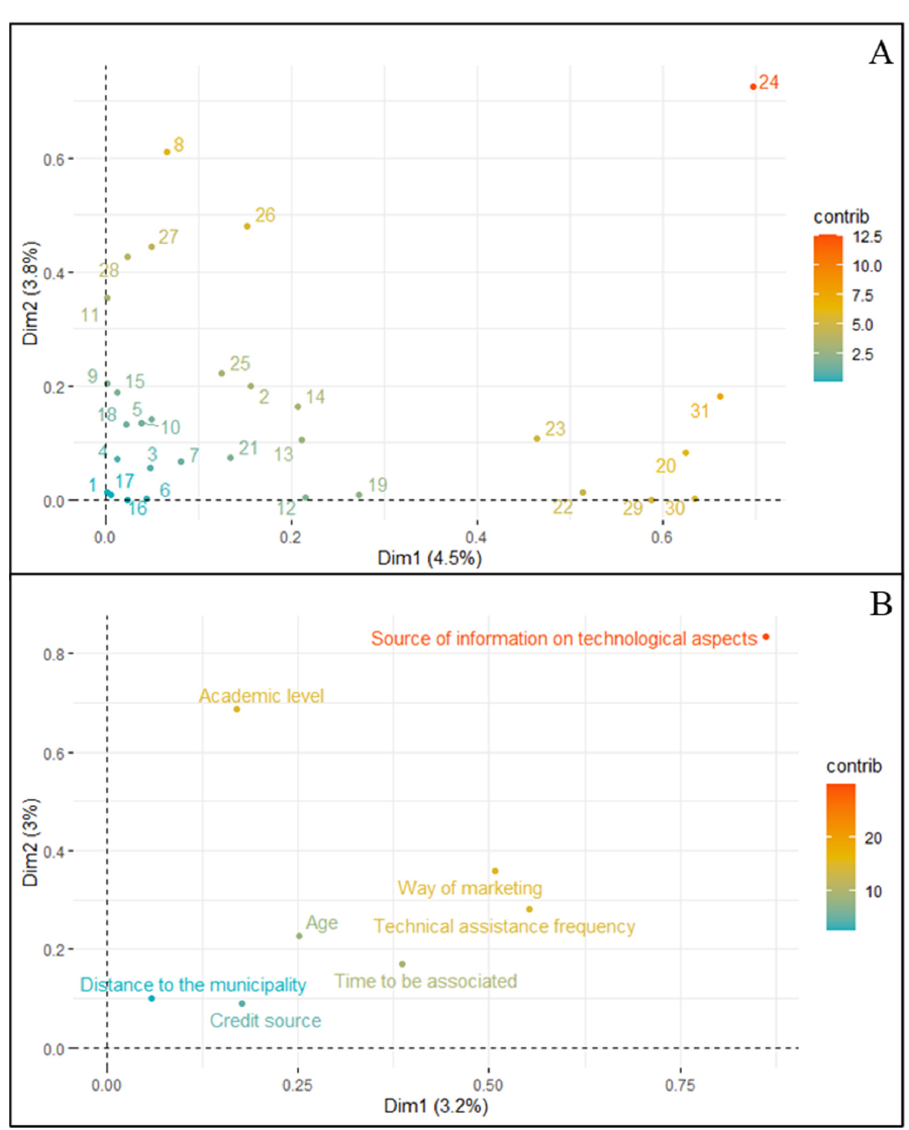
Figure 5. ( A ) Distribution and importance of variables of characterization of the producers according to the contribution that each of them has to explain variance of the data in the first two dimensions. Numbers were assigned to the variables to facilitate visualization. 1. Gender; 2. Age of the producer; 3. Distance to the municipal seat; 4. Land tenure; 5. Source of income; 6. Use credit; 7. Credit source; 8. Academic training; 9. Internet in production systems. 10. Smartphones in production systems; 11. Computers in production systems; 12. Keep records; 13. Linked to producer association; 14. Seniority in the association of producers; 15. Production system area; 16. Crop age; 17. Years of experience in cultivation; 18. Crop yield; 19. Sale price; 20. Marketing channel; 21.GlobalGAP; 22. Registration of export farm; 23. Percentage of rejection; 24. Source of information on technological aspects; 25. Causes of production reduction; 26. Recruitment of labor; 27. Payment of family labor; 28. Social security for workers; 29. Technical assistance; 30. Hiring technical assistance; 31. Frequency of Technical Assistance. ( B ) Socioeconomic variables with greater discrimination capacity associated with the NT of avocado producers in